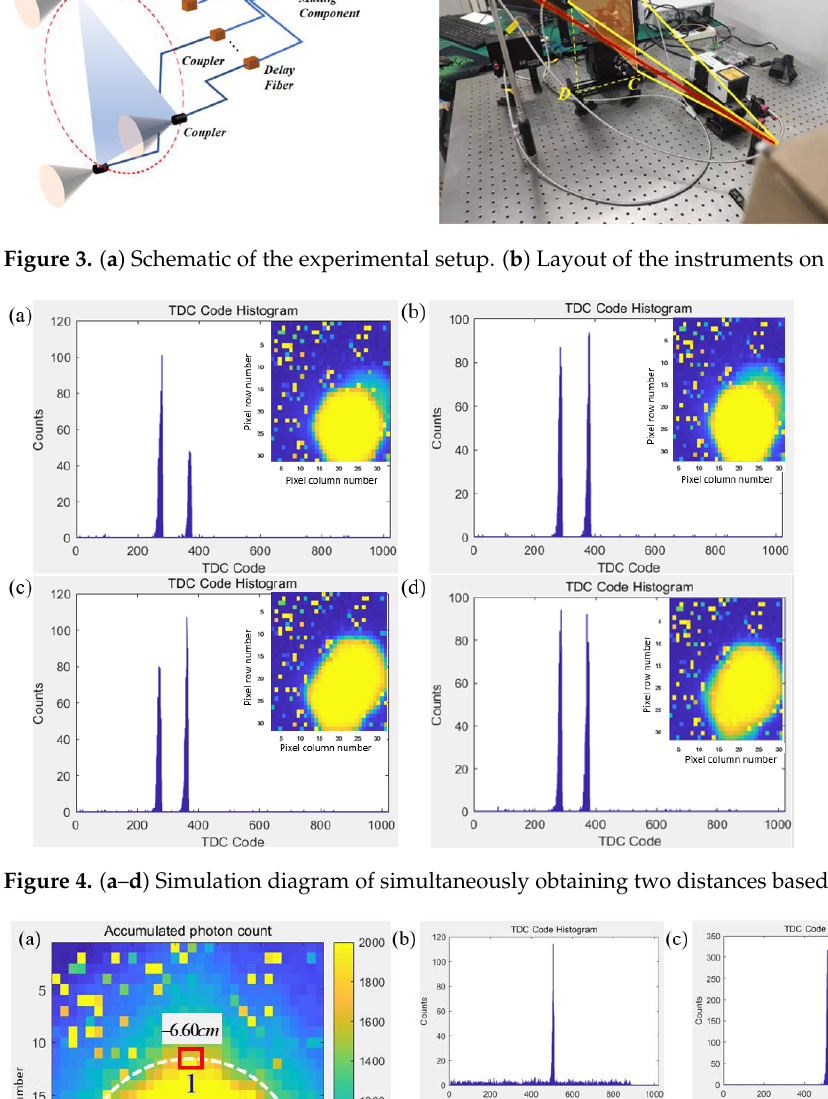
Figure 4. ( a – d ) Simulation diagram of simultaneously obtaining two distances based on time coding.